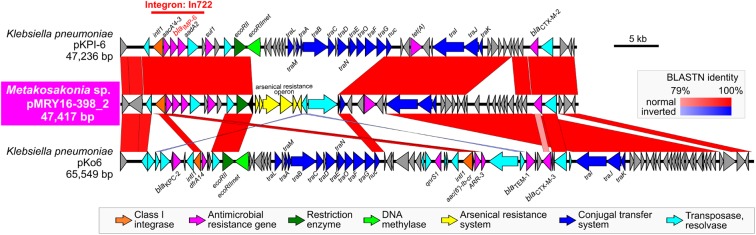
Structural comparison of the blaIMP-6-positive IncN plasmids. pMRY16-398_2 was aligned with IncN plasmid pKPI-6 (GenBank ID: AB616660) from Klebsiella pneumoniae KPI-6 isolated in 2007 in Japan. Homologous regions between the two are shown as red boxes with the color gradient corresponding to % homology. These plasmids carry the class 1 integron, In722 (intI1, aacA4’-3, blaIMP-6, aadA2, and gcISKpn22), classified in the INTEGRALL database (http://integrall.bio.ua.pt/) (Moura et al., 2009), and additional blaCTX-M-2 and tet (A).